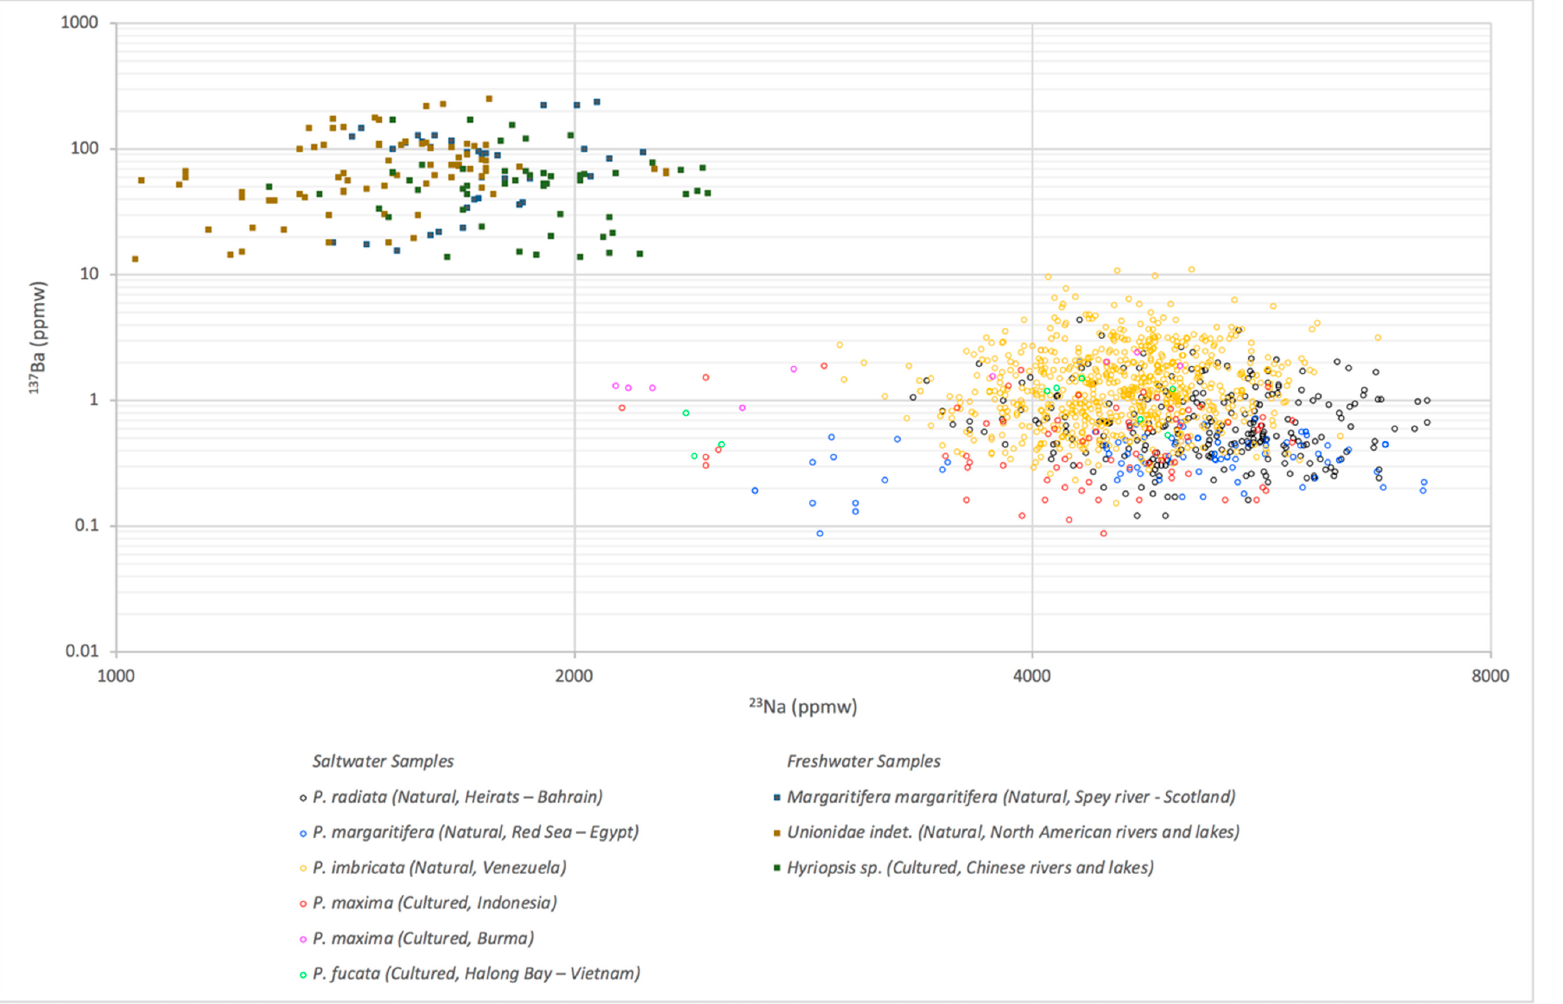
Figure 4. Binary plot of 137 Ba vs. 23 Na of the studied samples.